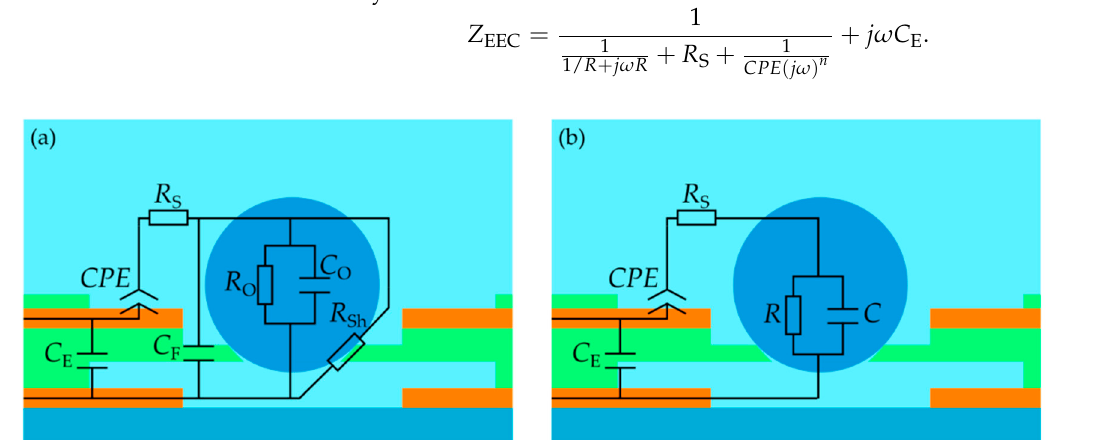
Figure 2. Schematic cross-section of the measurement unit with the equivalent electric circuit (EEC) on the object under test. ( a ) Full EEC. CPE : constant phase element of electrode/electrolyte interface, R S : solution resistance, R O : resistance of the object under test, C O : capacitance of the object under test, R Sh : shunt resistance near the rim of the aperture, C F : capacitance of the thin-film around the aperture, C E : crosstalk capacitance of vertically arranged electrodes at high frequencies. ( b ) Simplified EEC for fitting the electrical impedance spectroscopy (EIS) spectra. Drawing not to scale.